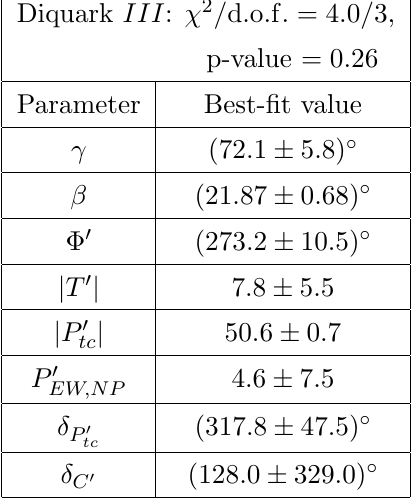
Table 11 . (cid:31) 2 = d : o : f : and best-(cid:12)t values of unknown parameters for the model of diquark III . min Constraints: B ! (cid:25)K data, measurements of (cid:12) and (cid:13) , j C 0 =T 0 j = 0 :